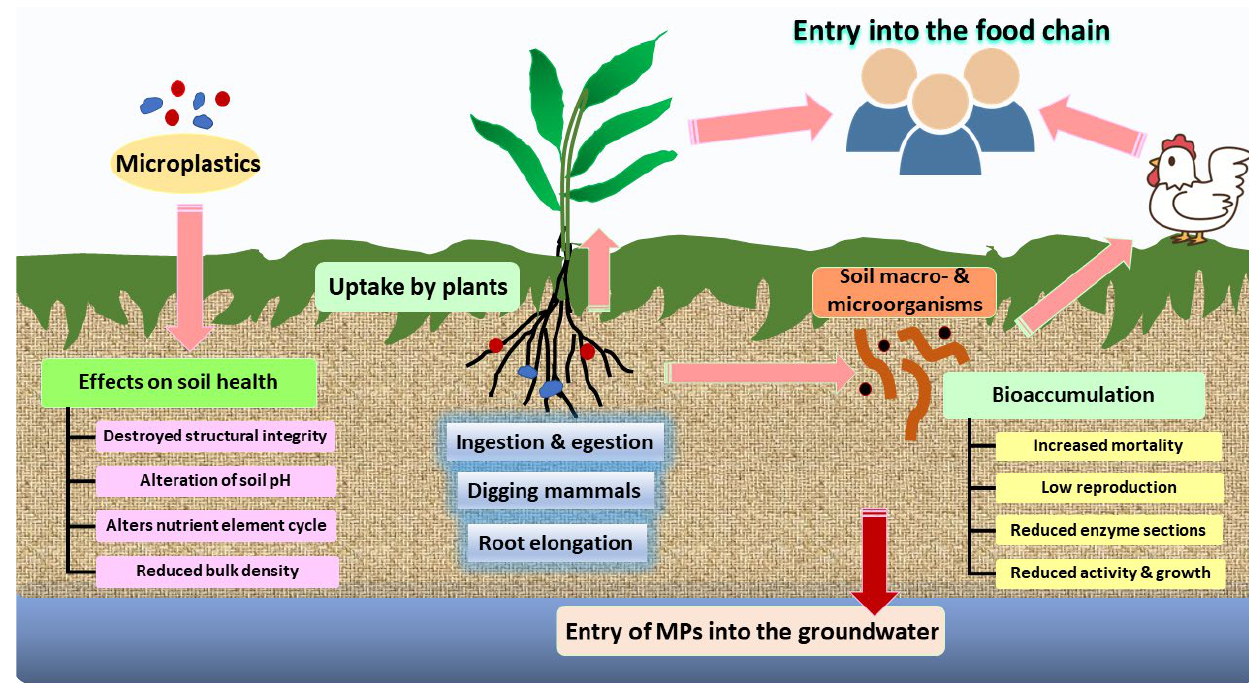
Figure 13. The toxic effects of microplastics on soil biota.